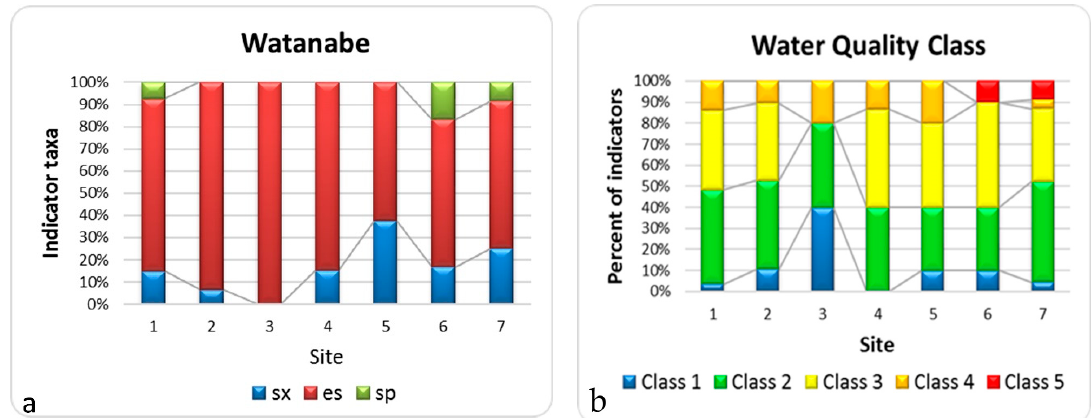
Figure 10. Ecological preferences of organic pollution indicators according to the Watanabe indicator system ( a ) and water quality classes according to indices of saprobity according to Sláde č ek ( b ) in the communities of studied sites in the Abraham Lincoln Birthplace National Historical Park. Abbreviations of site names follow those used in Tables 1 and 2. Abbreviation of ecological groups as in Table 3. Ecological groups of Saprobity indicators according to Watanabe: sx, saproxenes; es, eurysaprobes; sp, saprophiles. Class of water quality indicators are according to Sláde č ek indices of saprobity: Class 1–5 according to EU color code.